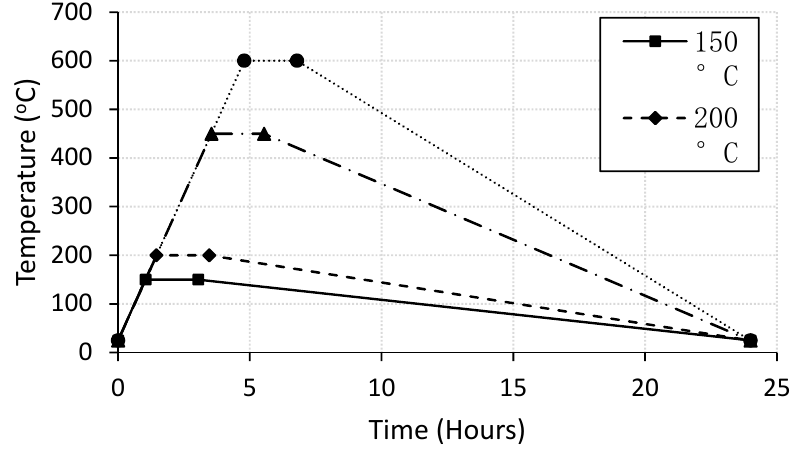
Figure 1. Temperature-time profiles.